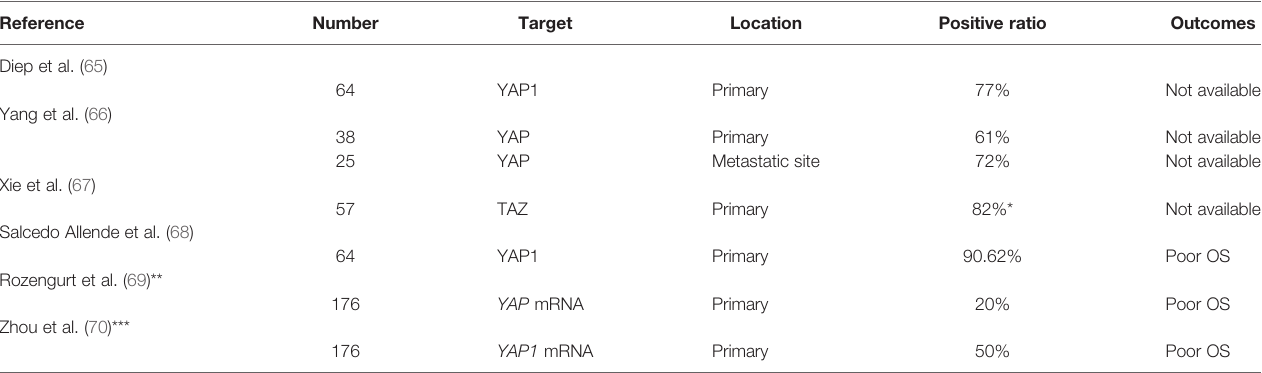
TABLE 1 | YAP/TAZ expression and functional relevance in human pancreatic